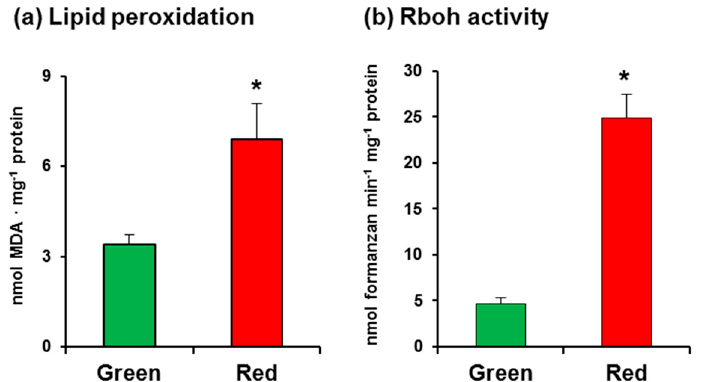
Figure 2. ( a ) Lipid peroxidation in pepper fruits. ( b ) Total respiratory burst oxidase homolog (Rboh) activity in pepper fruits. Data are the mean ± SEM of at least three independent biological replicates. Asterisks indicate that differences between values were statistically significant at p < 0.05.